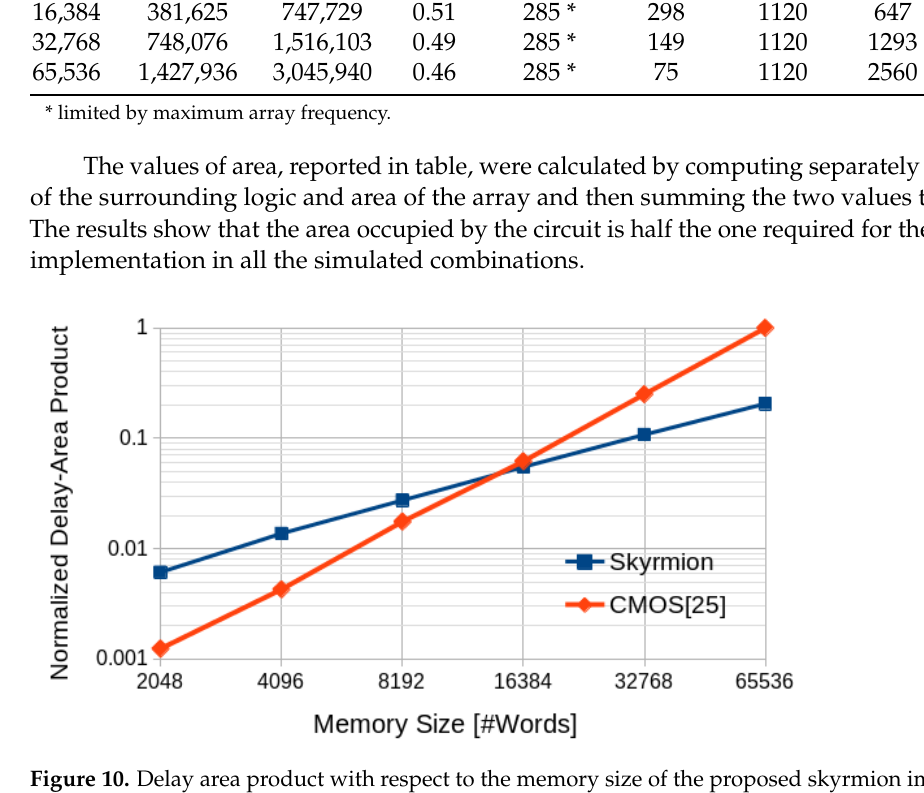
Figure 10. Delay area product with respect to the memory size of the proposed skyrmion implemen- tation and CMOS